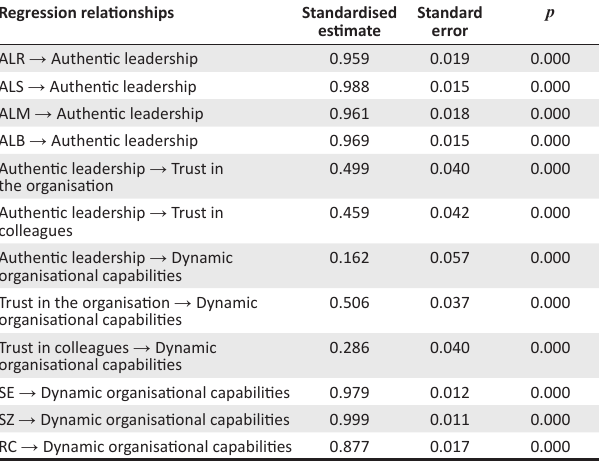
TABLE 6: Regression paths of the research model. Regression relationships